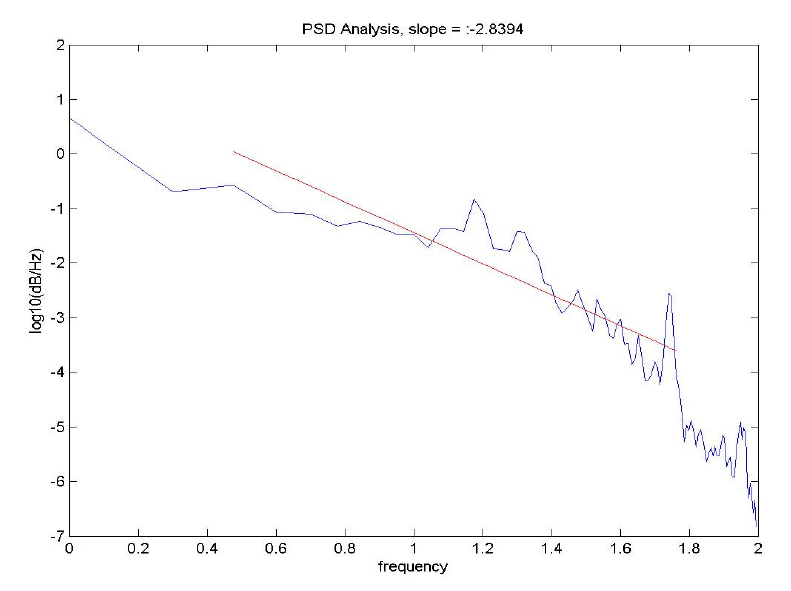
Figure 1. Linear regression analysis of PSD spectral slopes of the EEG spectrum of control partici- pant.